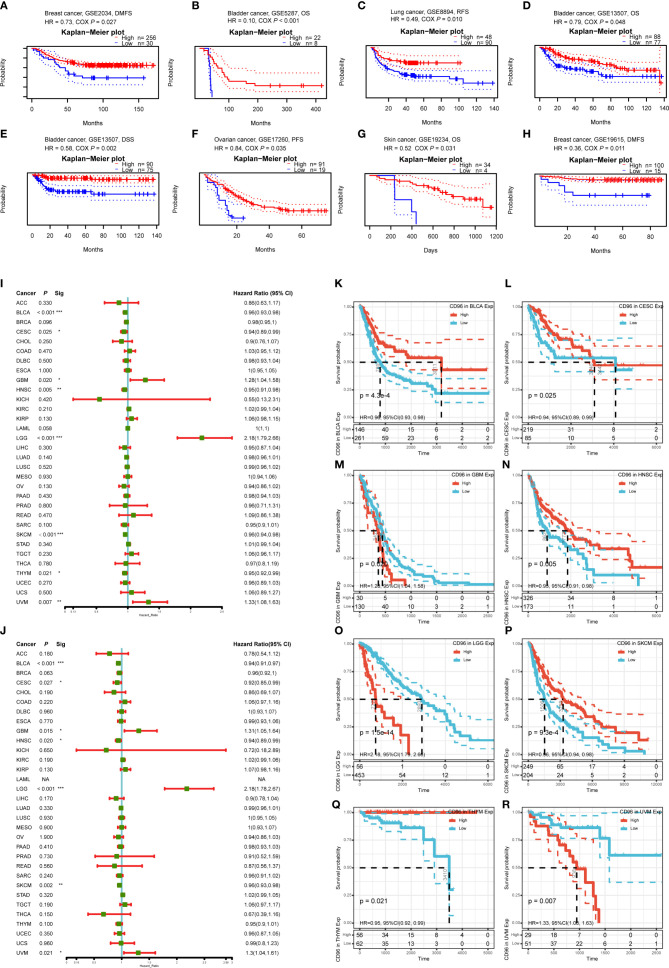
Survival analysis comparing the high and low expression of CD96 in different types of cancer in the GEO dataset and TCGA dataset. (A–H) Survival curves in eight cohorts (GSE5287, GSE13507, GSE19615, GSE2034, GSE17537, GSE8894, GSE17260, and GSE19234) with significance. (I, J) Relation between CD96 expression and patient prognosis (OS and DSS) of different cancers in TCGA database (*P < 0.05, **P < 0.01, ***P < 0.001). (K–R) Survival curves of OS with significance in eight cancer types (BLCA, CESC, GBM, HNSC, LGG, SKCM, THYM, and UVM) in TCGA.